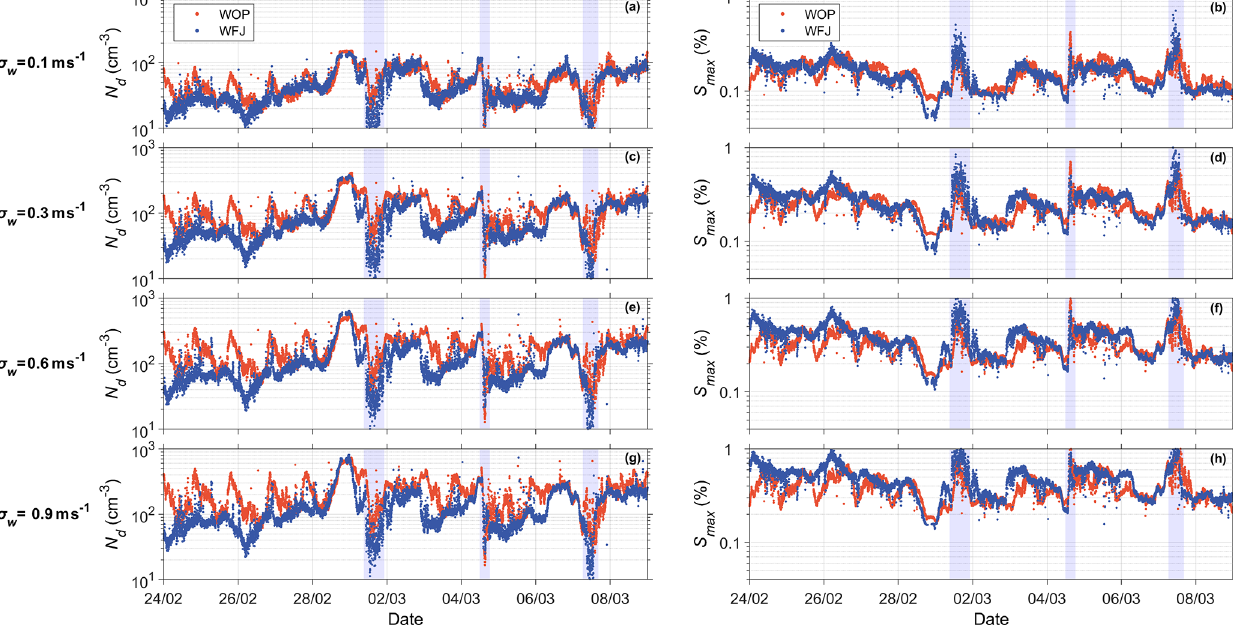
Figure 7. Calculated time series of N d (cm − 3 ) (left panels) and S max (%) (right panels) for updraft velocities of σ w = 0 . 1ms − 1 in panels (a) and (b) , 0.3ms − 1 in panels (c) and (d) , 0.6ms − 1 in panels (e) and (f) , and 0.9ms − 1 in panels (g) and (h) during the period of interest at WOP (orange dots) and WFJ (blue dots). The blue shaded areas represent the intense precipitating periods shown in Fig.